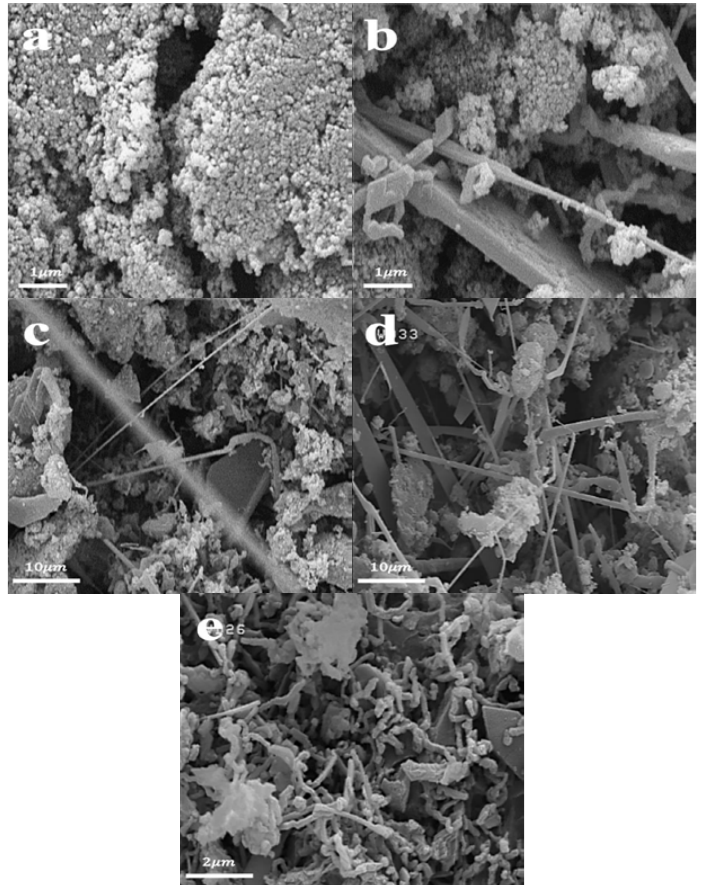
Fig. 6. The SEM image of the amount of the nanowires synthesized at 1500 ⁰C. (a) Sample B1 in which, no nanowire has been syn - thesized. (b) Sample B2 which contains nanowires and nanobelts. (c and d) Samples B3 and B4, respectively in which, increasing the amounts of nanowires and nanobelts can be observed. (c) The wires, nanobelts and nanoworms synthesized in sample